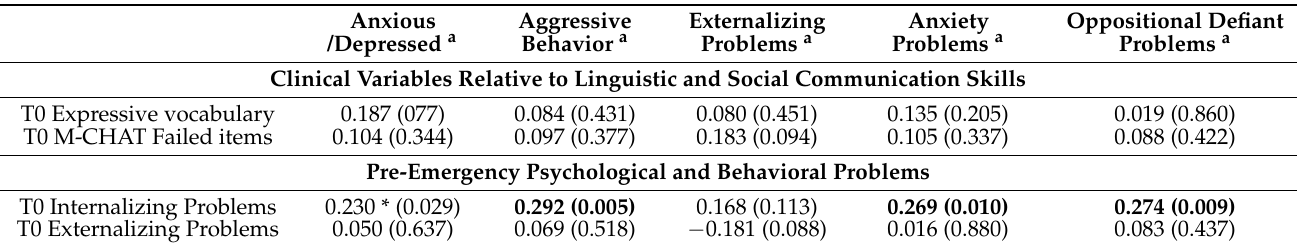
Table 3. Pearson correlation coefficients ( p -value) regarding associations between clinical variables at T0 (language and social communication skills, emotional and behavioral profile) and CBCL 1.5–5 scales showing significantly higher T scores at